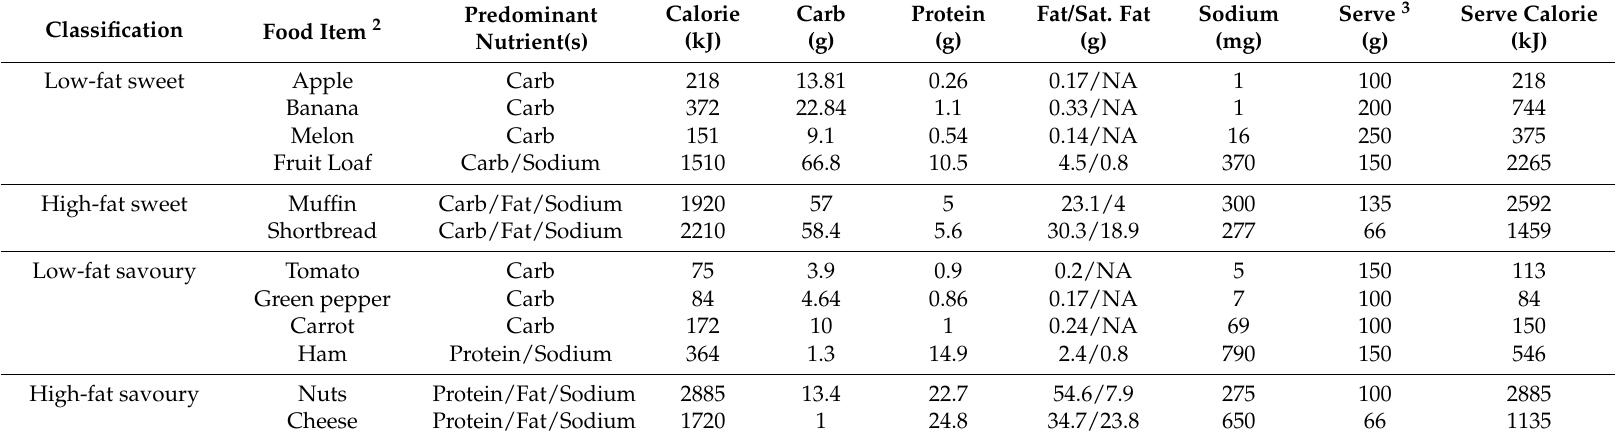
Table 2. Nutritional information for food items included in the buffet meal 1